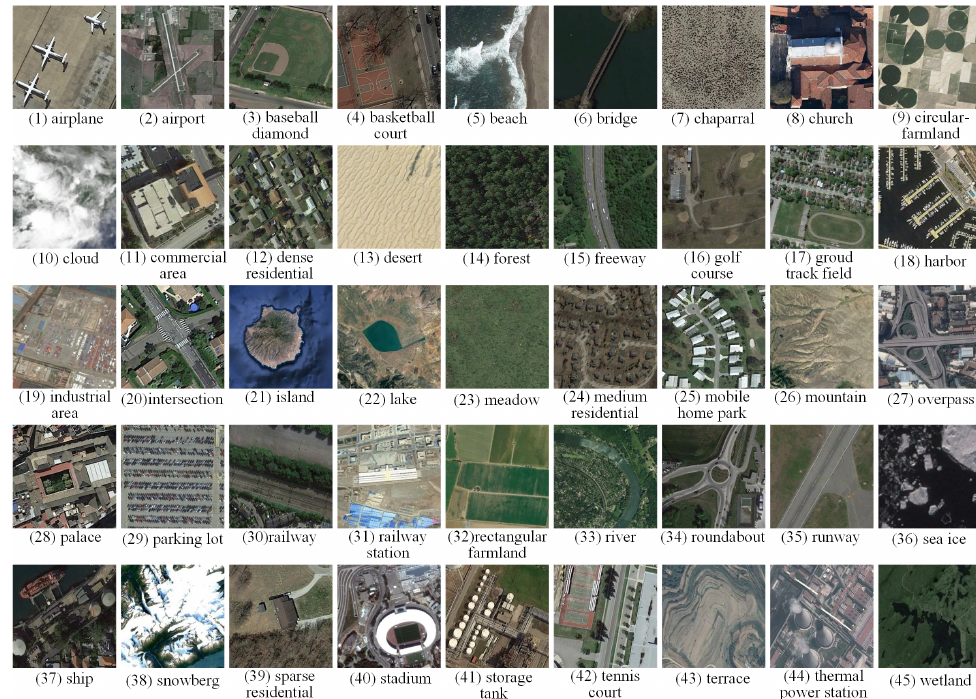
Figure 6. NWPU-RESISC45 dataset, the size of each scene image is 256 × 256, the pixel resolution of most scene classes is between 30 m and 0.2 m, and the 45 classes of this dataset include airplane, airport, baseball diamond, basketball court, beach, bridge, chaparral, church, circular farmland, cloud, commercial area, dense residential, desert, forest, freeway, golf course, ground track field, harbor, industrial area, intersection, island, lake, meadow, medium residential, mobile home park, mountain, overpass, palace, parking lot, railway, railway station, rectangular farmland, river, roundabout, runway, sea ice, ship, snowberg, sparse residential, stadium, storage tank, tennis court, terrace, thermal power station, and